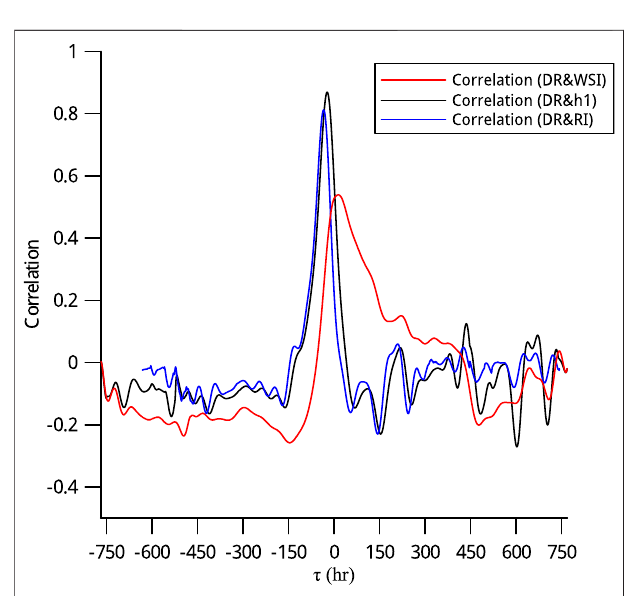
FIGURE 12 | Correlation functions. One month time series data from 7/ 28/2009 are used for calculation. The negative time shift (negative τ ) representsthetimeleadtotheDR. Thelargehorizontaltimelagaxis ischosen for clearer visual inspection of the correlation functions.